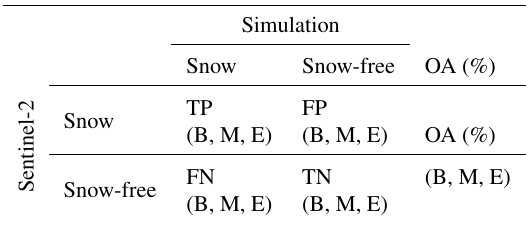
Table 2. Example of the confusion matrix used in the “Results” section. The analysis was split into three periods: beginning (B: October–November–December), middle (M: January–February), and end (E: March–April–May) of the season. TP: true positive; FP: false positive; FN: false negative; TN: true negative; OA: over- all